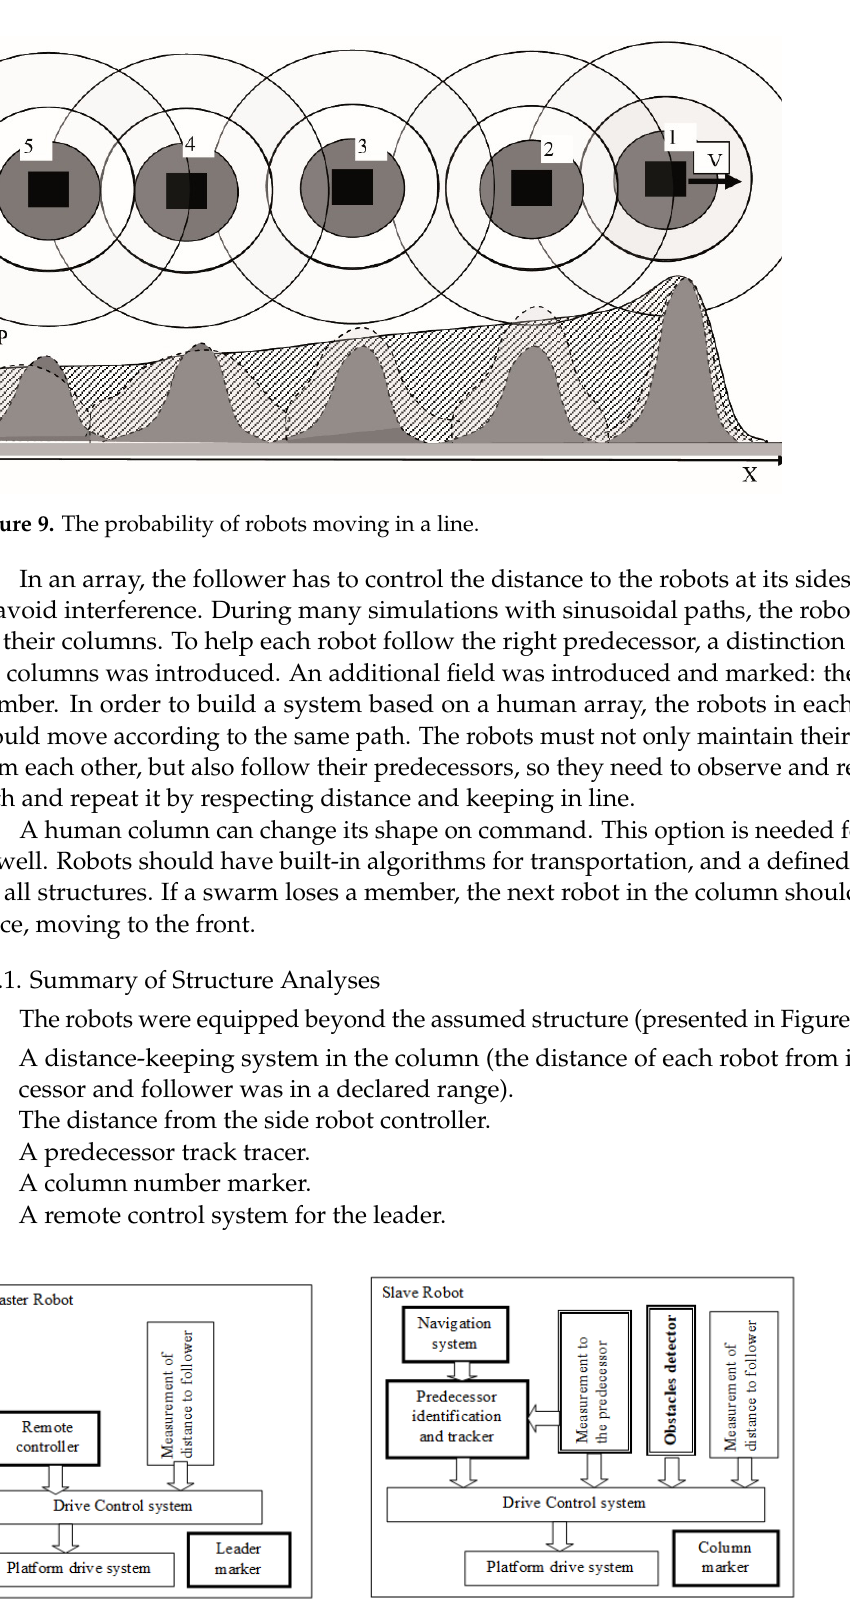
end Figure 11. The array of robots passes over the obstacles. Effects: A controller for the distance between the robots was introduced. To maintain the dynamics of the swarm, the robots needed a power reserve. As the lineup of the rows was not important, this result was acceptable.